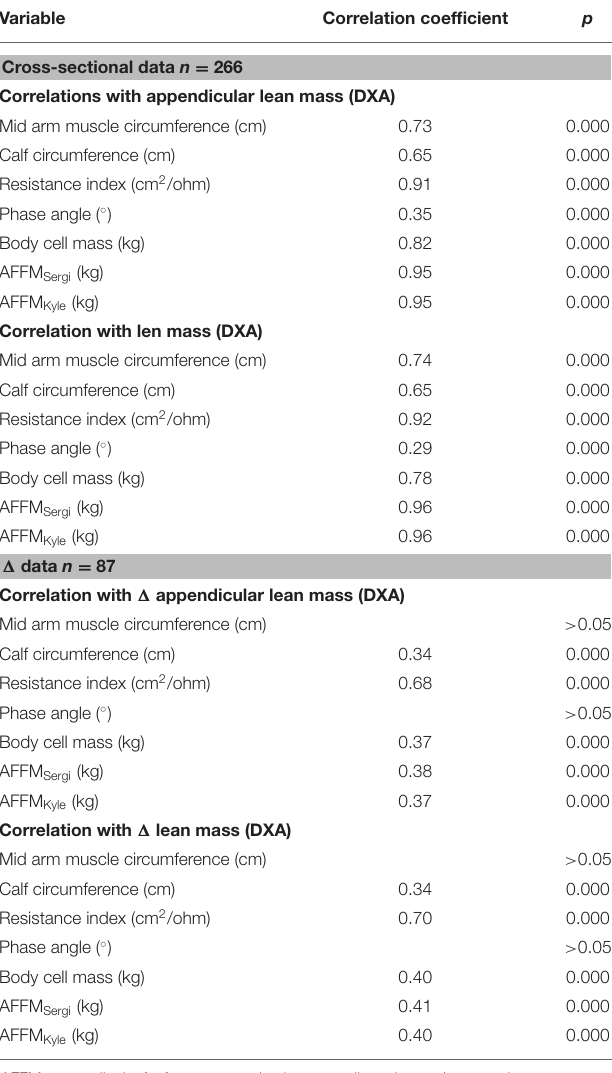
TABLE 7 | Correlations between surrogate methods and DXA in total sample ( n = 266).